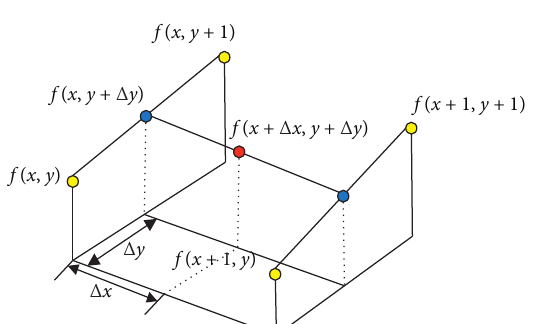
Figure 3: Schematic diagram of bilinear interpolation algorithm.